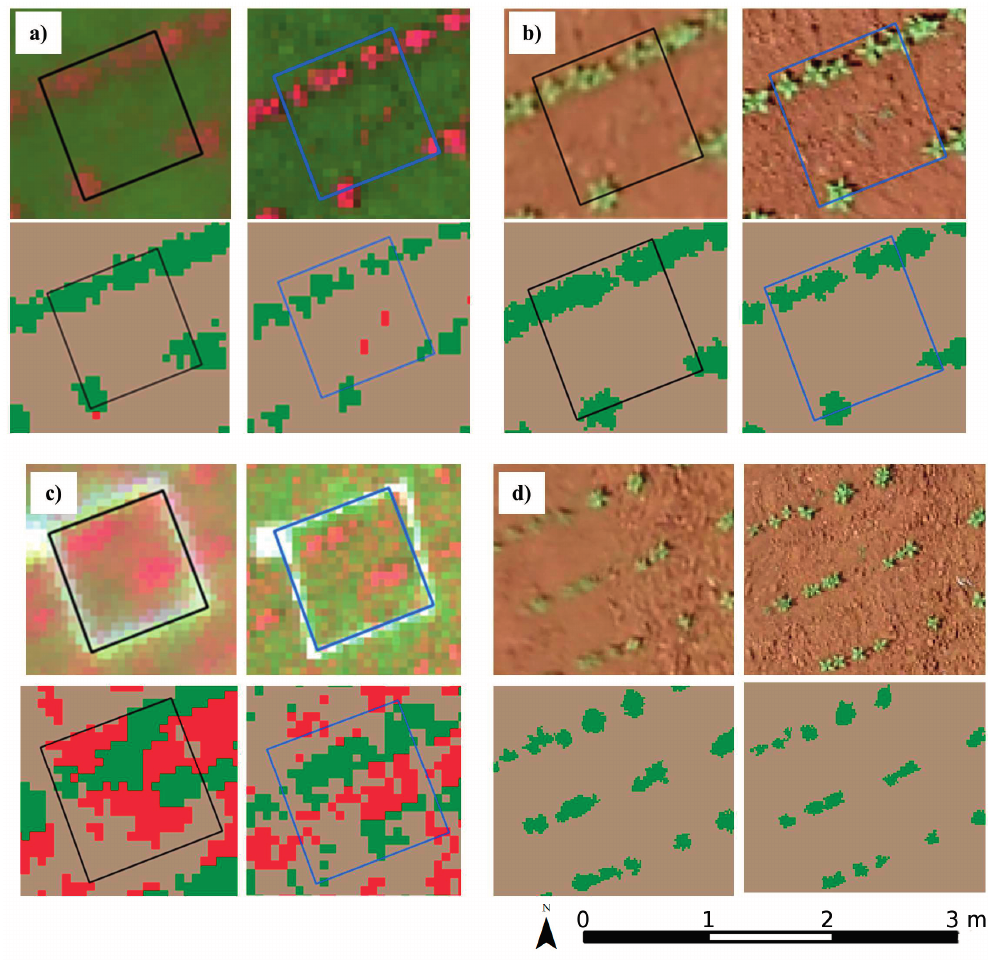
Figure 7. Examples of events that occurred in the classification of frames between UAV-image (left) and RS-image (right) for both sensors. Upper and bottom figures display the ground truth data of corresponding squared frames and classified image, respectively. Sunflower crop rows and weeds are represented in green and red color, respectively. ( a ) UAV-image using TTC at 100 m altitude and RS-image at 100 m (weed is detected only in the RS-image); ( b ) UAV-image using RGB at 60 m altitude and RS-image at 60 m (weed is not detected in any case); ( c ) UAV-image using TTC at 100 m and RS-image at 100 m (mixture between line crop and weed pixels); and ( d ) UAV-image using RGB at 60 m altitude and RS-image at 60 m (distortion in the UAV-image avoids a correct crop shape